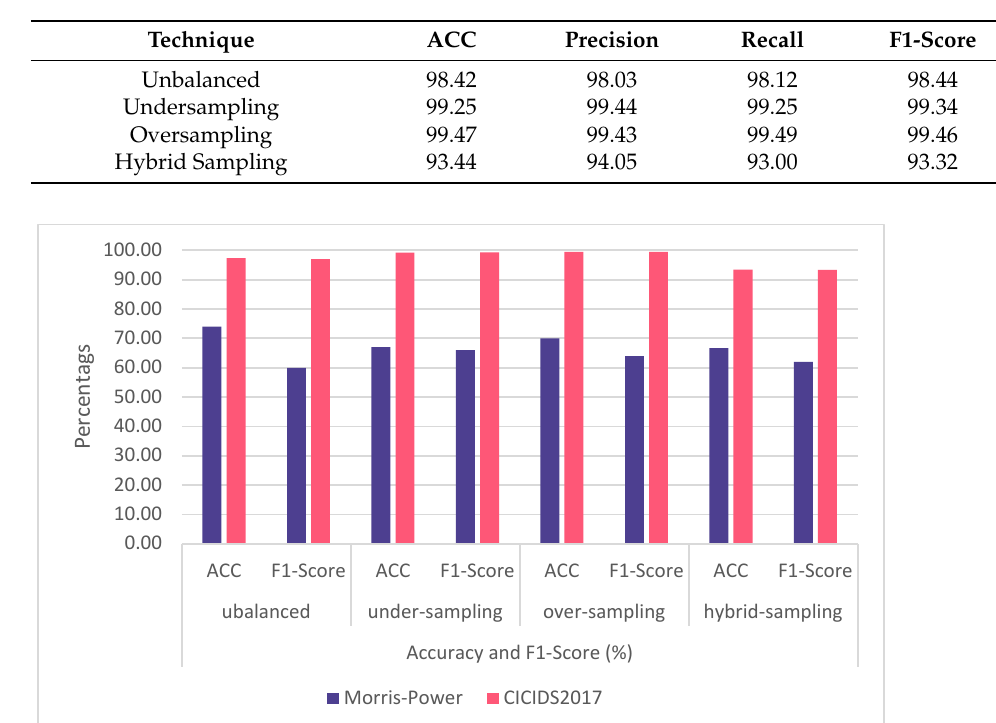
Table 16. Overall results for the CICIDS2017 Dataset.